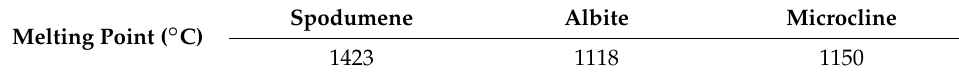
Table 1. Characteristic temperatures of the synthetic components of the